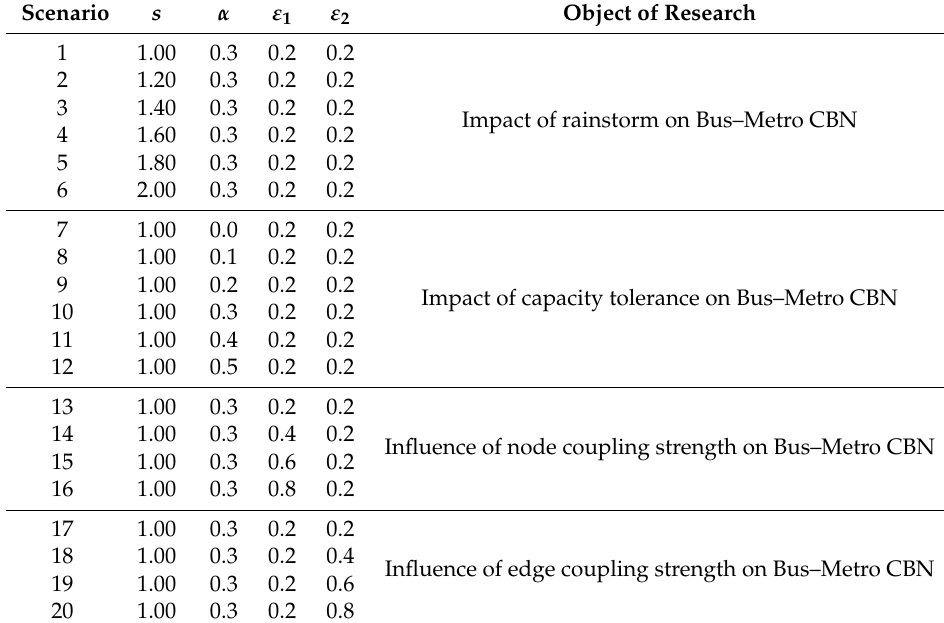
Table 4. Simulation